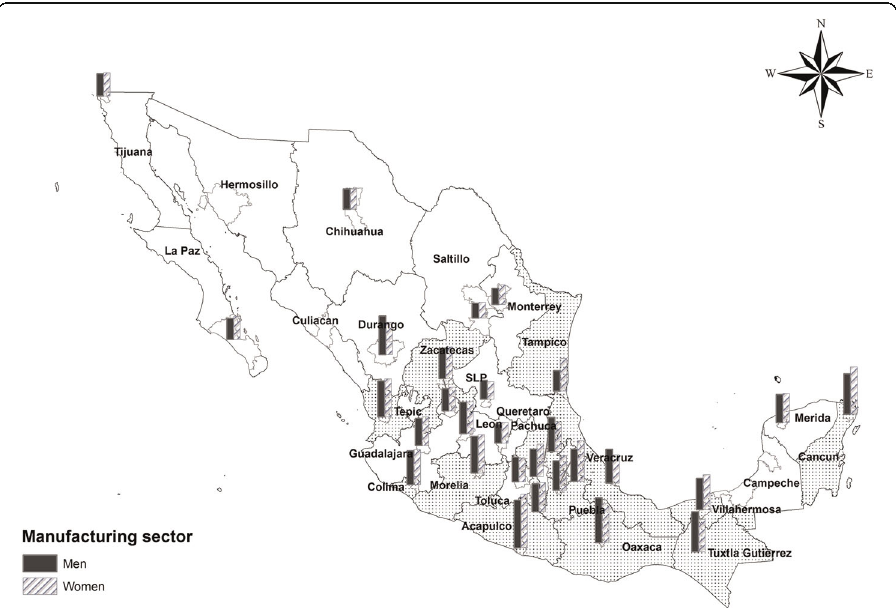
Fig. 1 Precariousness in the manufacturing sector, 2018. Source: Author ’ s extrapolation with data from the